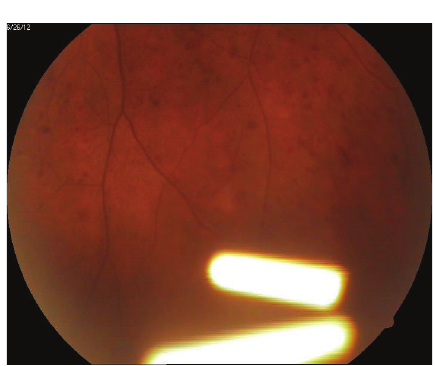
Figure 2: Splitted Ozurdex implant in the lower part of the vitreous.